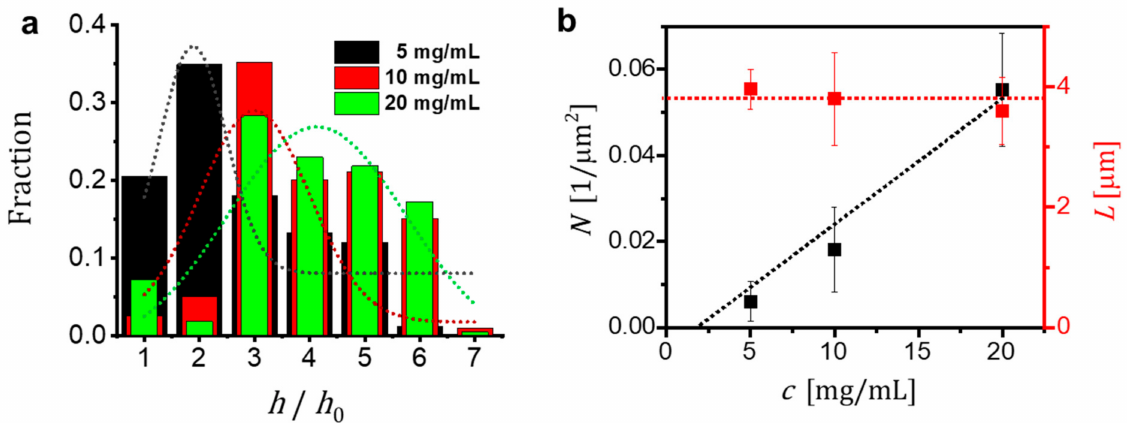
Figure 3. Influence of polymer concentration ( c ) on the number density and size of the crystals. Samples were crystallized at T C = 20 ◦ C for 24 h after self-seeding T SS = 40 ◦ C for 30 min. ( a ) Fraction of crystals as a function of their thickness ( h ) normalized by the thickness h 0 ≈ 20 nm of a mono-lamellar crystal formed at T C = 20 ◦ C. The black, red and green bars represent the results obtained for c being 5, 10 and 20 mg/mL, respectively. The dotted lines represent the corresponding fits assuming a Gaussian distribution; ( b ) Number density ( N ) and side length ( L ) of the obtained